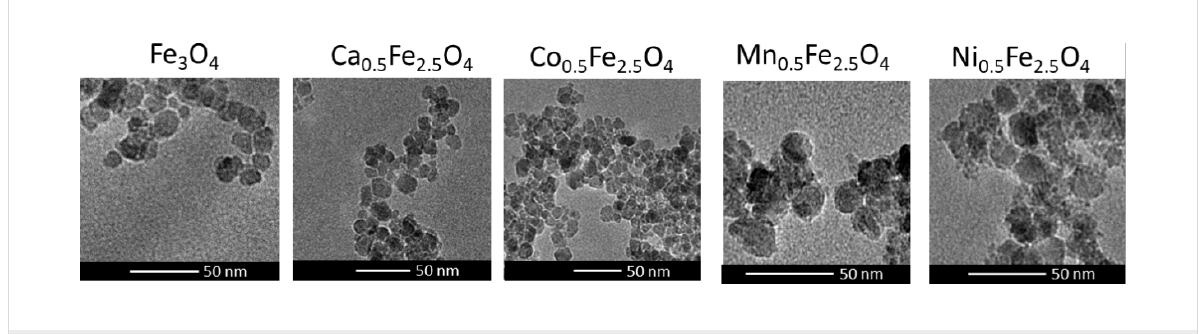
Figure 2: TEM images of prepared ferrite nanoparticles.